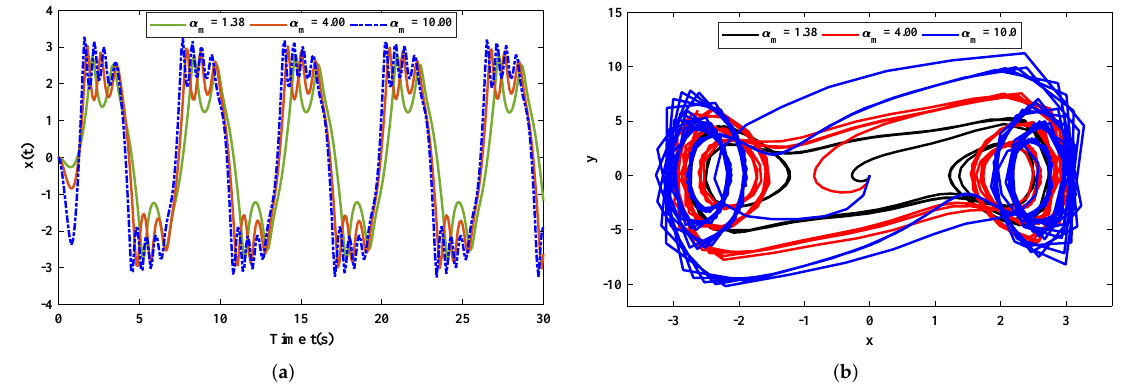
Figure 9. ( a ) Demonstrates the influence of variations in α m on the rolling motion of ships. ( b ) Phase-space diagram of y ( t ) against x ( t ) for different values of the maximum slope.